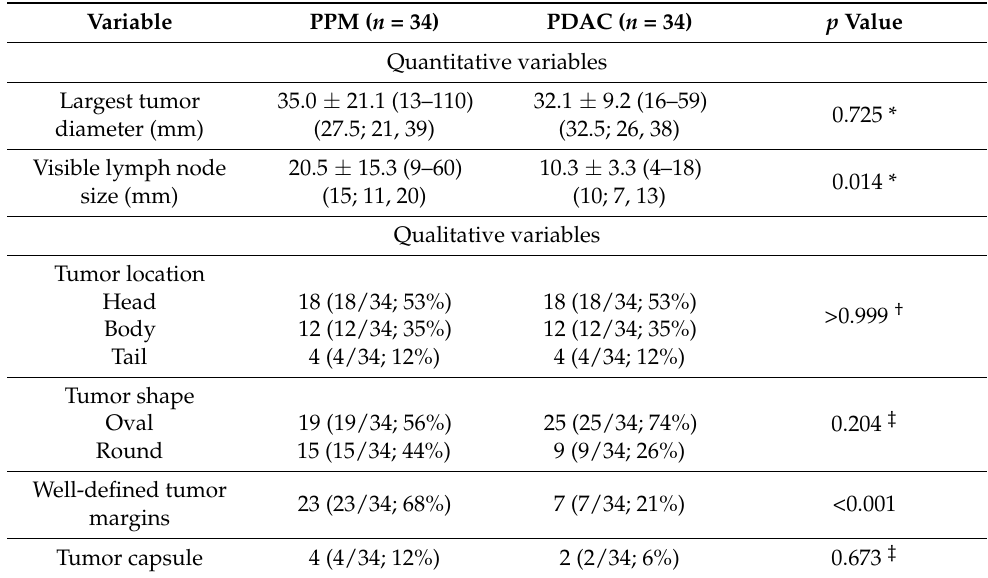
Table 3. Comparison of CT imaging findings between 34 patients with pancreatic parenchyma metastasis and 34 patients with pancreatic ductal